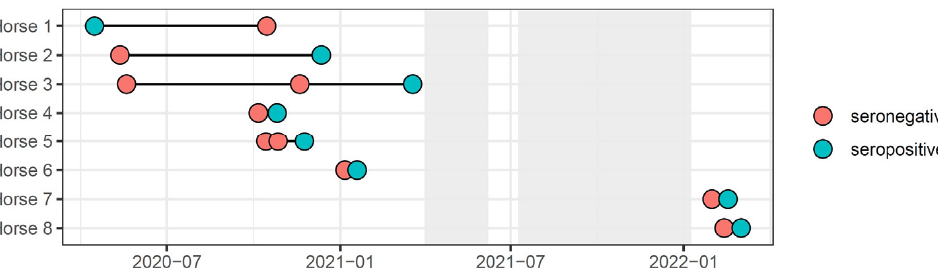
Figure 1. Timeline of blood samples from 8 horses with antibody titer changes against SARS-CoV-2. Individual horses are listed with continuous numbers (Horse 1–8). Temporal ELISA titers against SARS-CoV-2 are expressed as positive (orange circle) or negative (blue circle). The shaded areas represent periods with no sample collections. Table 1. Signalment (age, breed, sex), presenting complaint, and season of presentation in 1186 equids tested for antibodies against SARS-CoV-2.